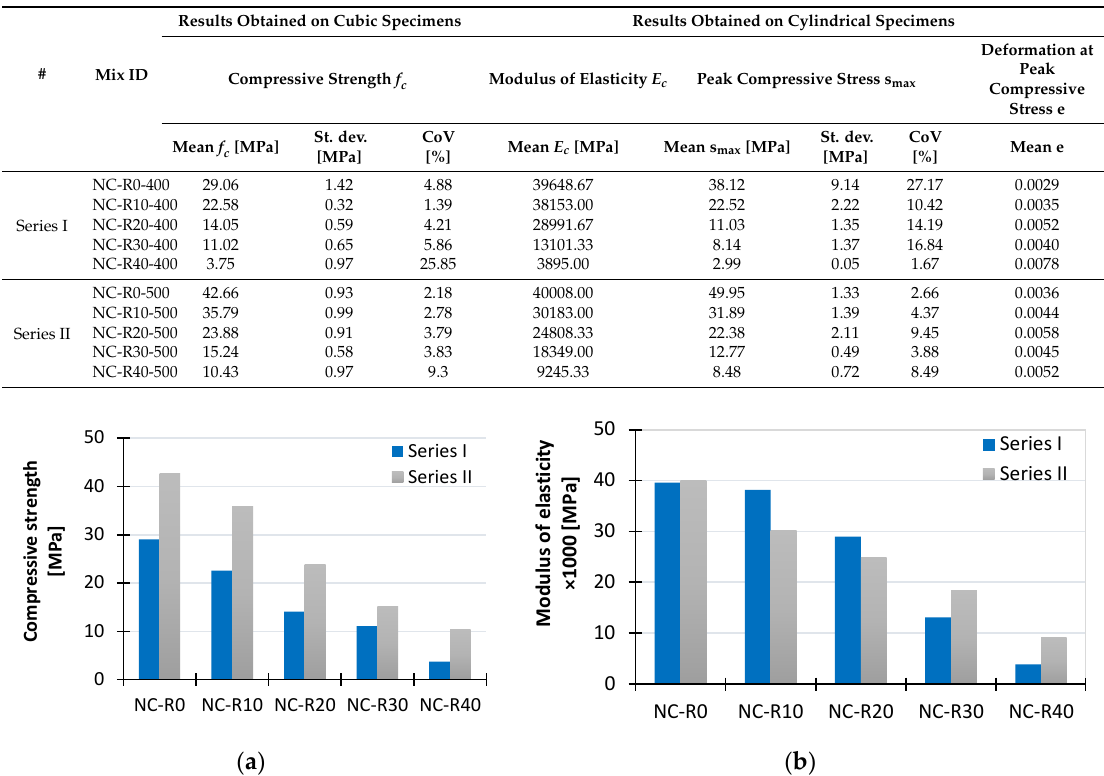
Figure 6. ( a ) Compressive strength test results on cubic specimens; ( b ) elastic modulus test results on cylindrical specimens.